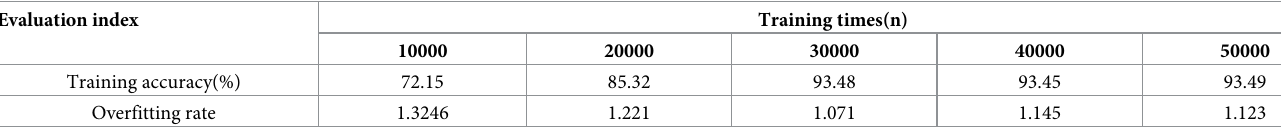
Table 1. Comparison of results of different training